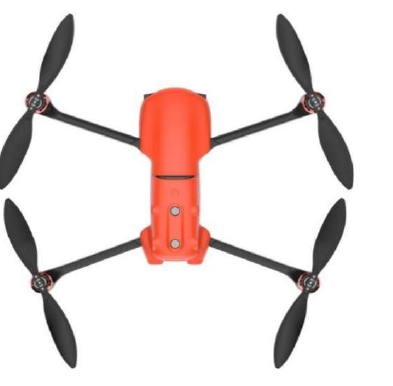
Figure A1. The drone used in this study: Autel Robotics EVO II Pro 6K.